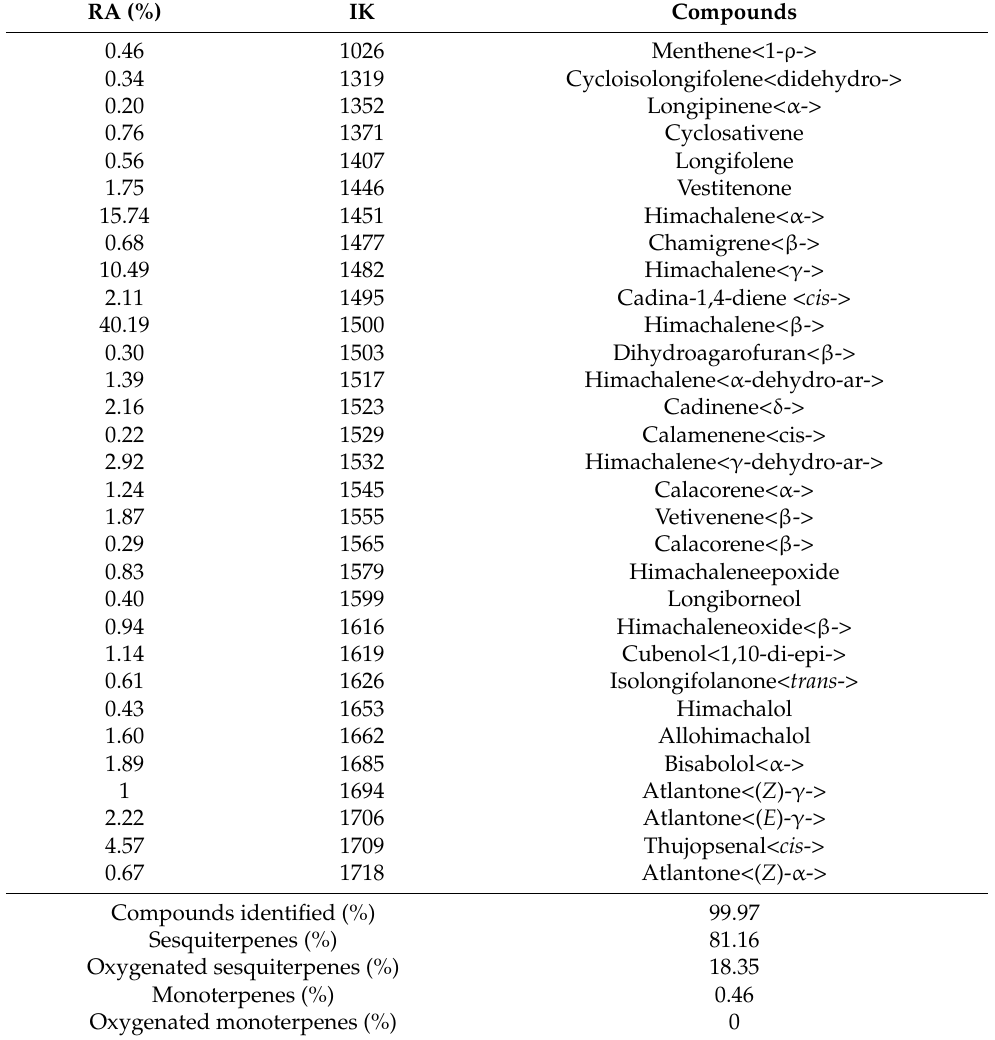
Table 9. The chemical composition of EO of Cedrus atlantica